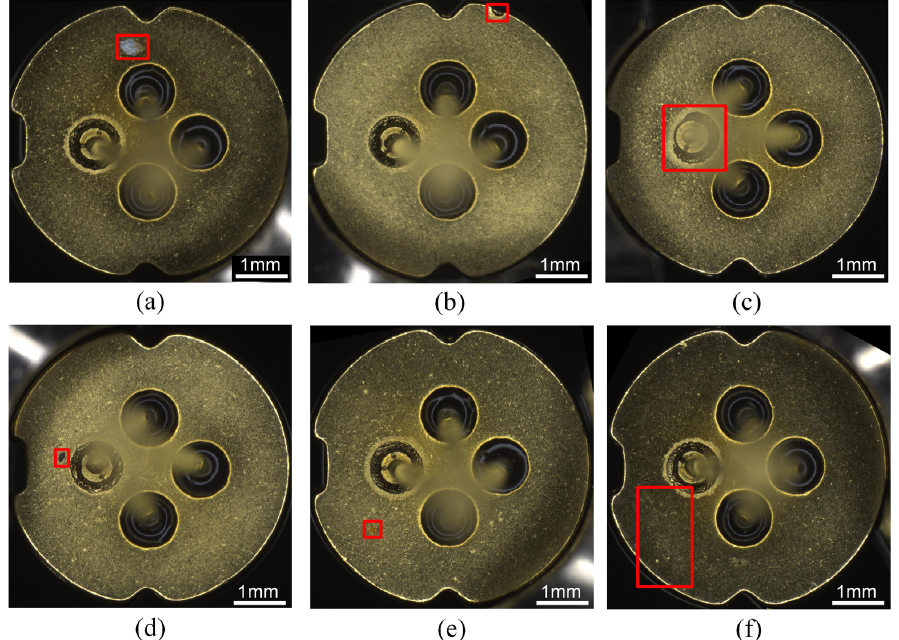
Figure 2. Six typical appearance defect images and labels of metal TO-base. ( a ) Baiban: patchy defects on the plated surface; ( b ) Quesun: defective parts; ( c ) Yinbujun: uneven bonding of conductive silver paste; ( d ) Zhanyin: conductive silver paste contaminates the surface; ( e ) Xiuji: flaky or dotted rust on the surface; ( f ) Huahen: scratches greater than 1mm in length or 0.03 mm in depth.